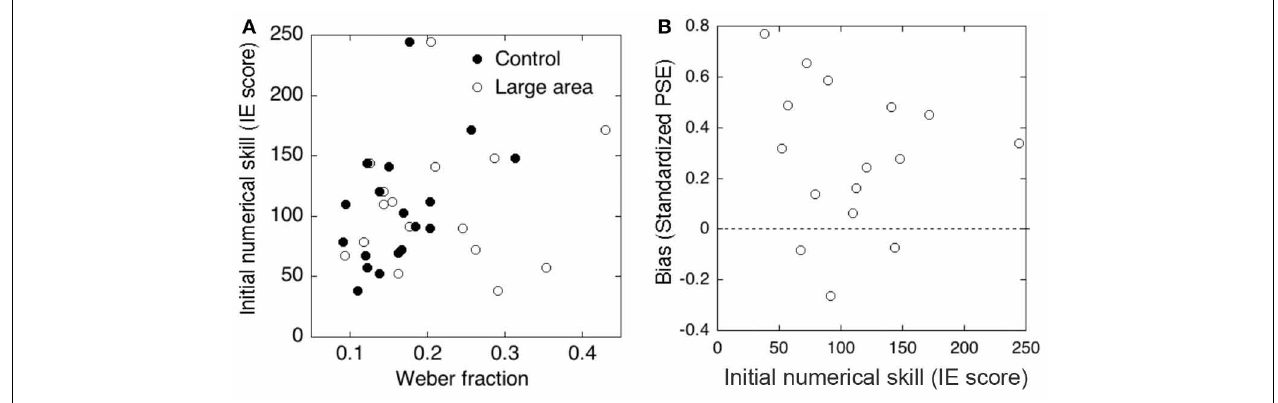
FIGURE 7 | (A) Correlations between the Weber fraction and the initial numerical skill (inverse efficiency scores) in the control and large element conditions. (B) Correlation between the initial numerical skill and the standardized PSE (i.e., size of